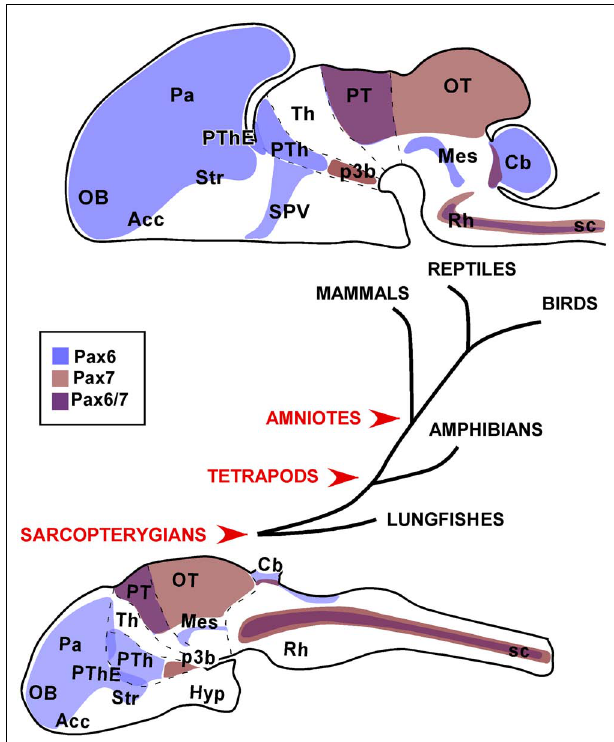
FIGURE 9 | Schematic representations of the distinct neuroanatomical regions that were consistently observed with Pax6 and Pax7 expression in the brain of the species studied. The drawings correspond to sagittal views of the brains of a postnatal amniote (upper drawing) versus a juvenile anamaniote (lower